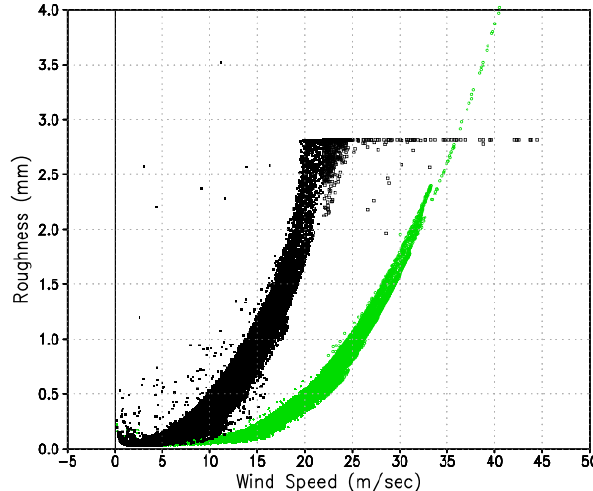
Table 2. Experiments to attribute MERRA to MERRA2 AGCM simulation changes to changes in parameterizations.